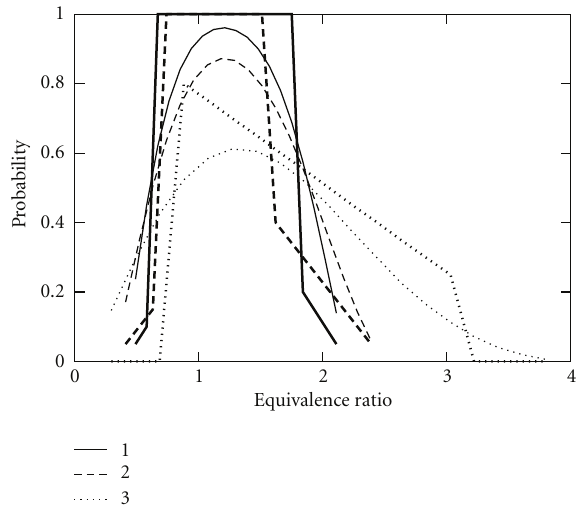
Figure 15: Dependencies of the normalized mean laminar flame speed s L on the mean equivalence ratio F , calculated invoking the beta-function (thin curves) and R-2 δ (bold curves) PDFs for di ff erent g f specified in legends. F min = 0 . 5 and F max = 1 . 9.